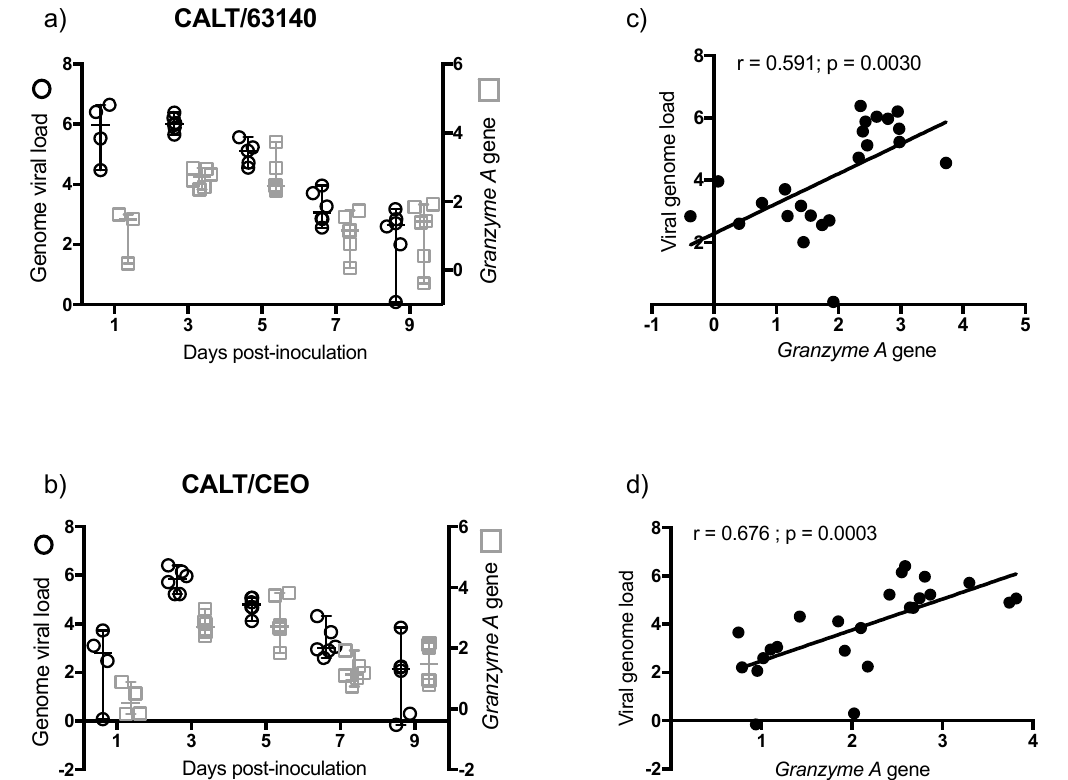
Figure 6. Transcription of the Granzyme A gene in relation to genome viral load in the conjunctiva-associated lymphoid tissue (CALT). Individual median fold change (log 10 2 − ∆∆ C t ) transcription of the Granzyme A gene in the CALT of 63140 ( a ) and CEO ( b ) groups are presented in the y right axis (open square), with the median represented as the horizontal line and the 95% confident interval as the vertical line. Individual mean genome load (log 10 2 − ∆∆ C t ) in the CALT of 63140 ( a ) and CEO ( b ) groups are presented in the y left axis (open circle), with the mean represented by the horizontal line and the standard deviation as the vertical line. Pearson correlation between Granzyme A expression and genome load from 3 to 9 dpi were determined for CALT / 63140 ( c ) and CALT / CEO ( d ). Pearson correlation and linear regression analysis for x = Granzyme A gene expression and y = viral genome load was performed for 63140 ( c ) and CEO ( d ) groups. Correlation coe ffi cient (r) and p values are presented.